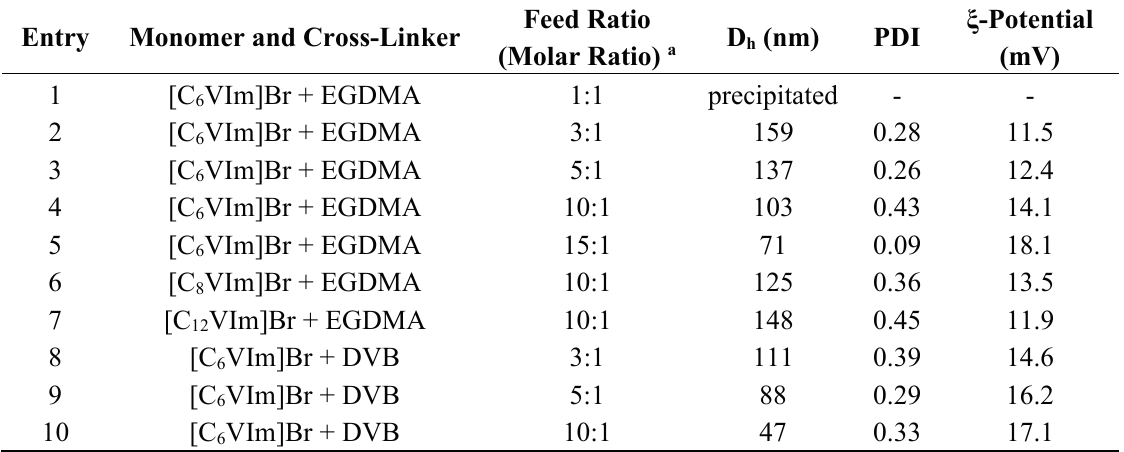
Table 1. Size, PDI, and ζ -potential of nanogels prepared with different feed ratios in methanol. Entry Monomer and Cross-Linker